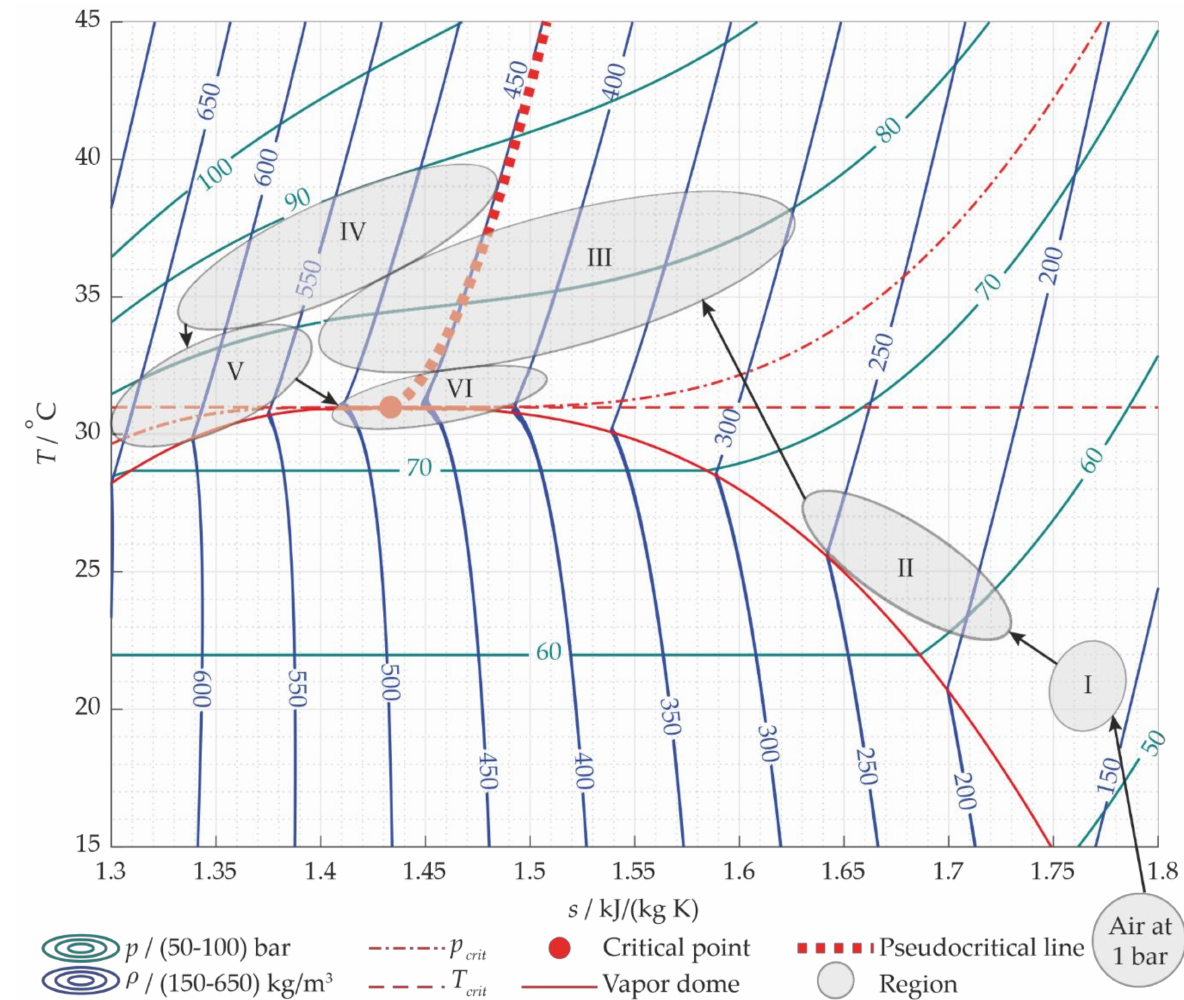
Figure 6. Regions of compressor inlet conditions during steps of initial operation depicted in T-s- diagram for CO 2 with lines of constant pressure ( p ) and density ( ρ